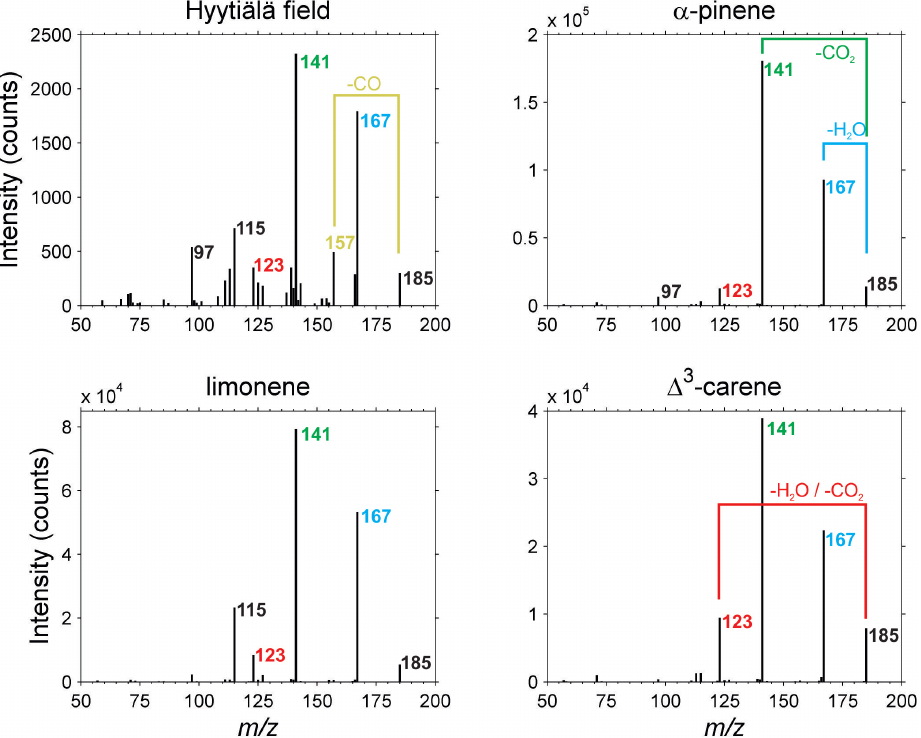
Fig. 6. Online MS 2 experiments at Hyyti¨al¨a (CID energy 30%) and from laboratory ozonolysis using α -pinene, limonene and 1 3 -carene (CID energy